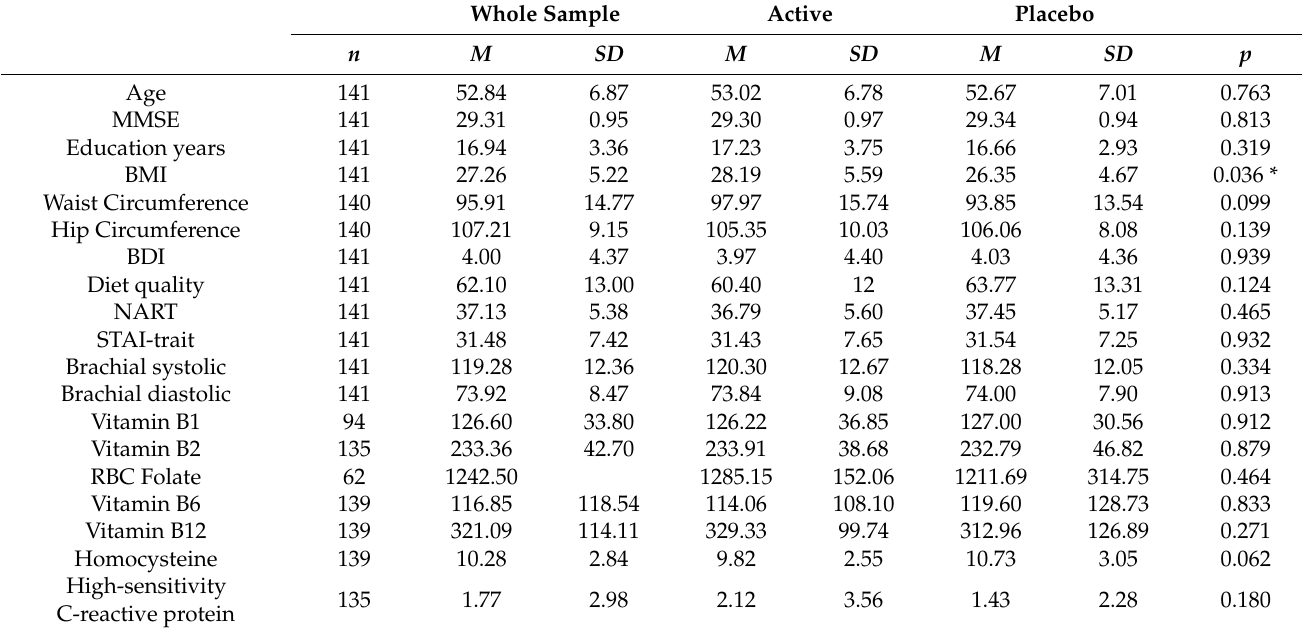
Table 1. Sample characteristics for entire cohort and by treatment allocation at baseline. Whole Sample Active